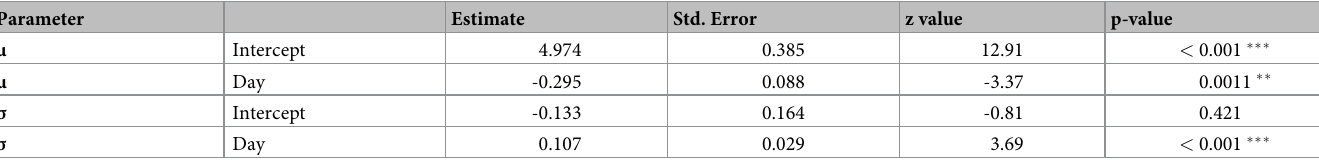
Table 4. Fixed effects of a GAMLSS predicting relative amount of time spent at home, as compared to pre-illness.